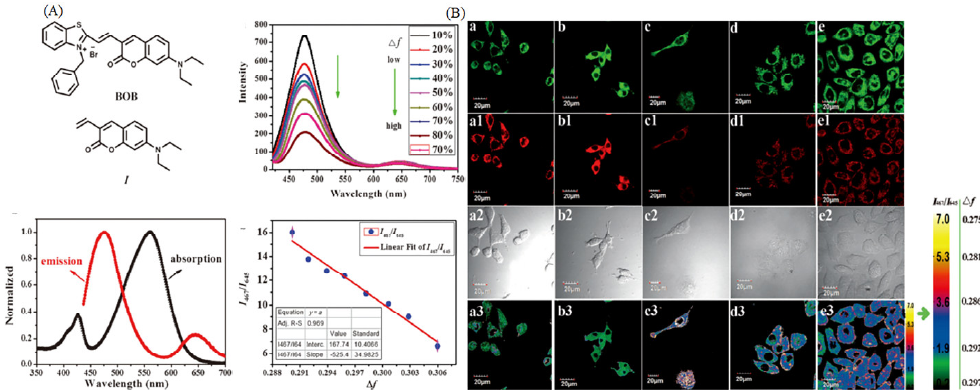
Figure 19. ( A ) Molecular structures, normalized absorption and emission of BOB. ( B ) Confocal of difference type of cells (cos-7 cells a1 – a3 , RAW 264.7 cells b1 – b3 , HeLa cells c1 – c3 , HepG2 cells d1 – d3 , and MCF-7 cells e1 – e3 ) incubated with BOB and the ratio images. Green channel pictures: a – e ; Red channel pictures: a1 – e1 ; DIC pictures: a2 – e2 ; Ratio pictures: a3 – e3 . Reproduced from [100] with permission of the Wiley, copyright 2015.